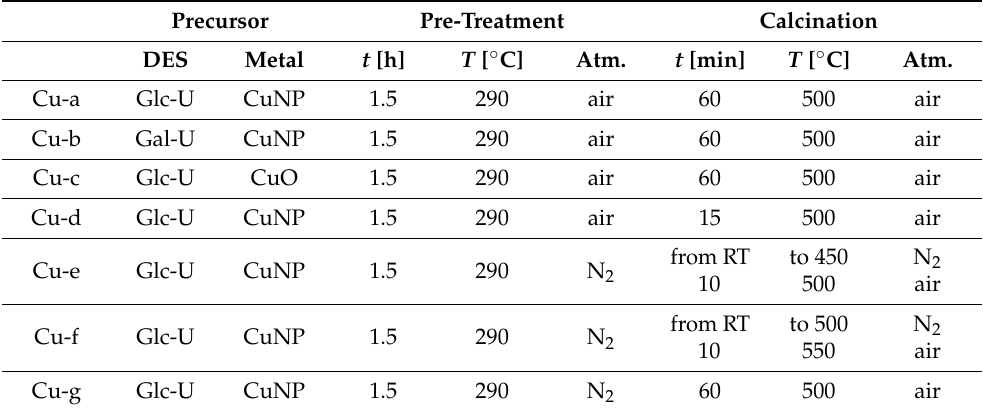
Table 2. Overview of the different preparation parameter. The following abbreviations correspond to Glc-glucose, Gal-galactose, U-urea, CuNP-copper nanopowder, RT-room temperature. Cu-e and Cu-f were prepared in two steps: pyrolysis under inert atmosphere and oxidative treatment for 10 min. The CuO-60 catalysts are Cu-a, Cu-b, Cu-c, and Cu-g. Precursor Pre-Treatment Calcination DES Metal t [h] T [ ◦ C] Atm. t [min] T [ ◦ C] Atm. Glc-U CuNP 1.5 290 air 60 500 air Gal-U CuNP 1.5